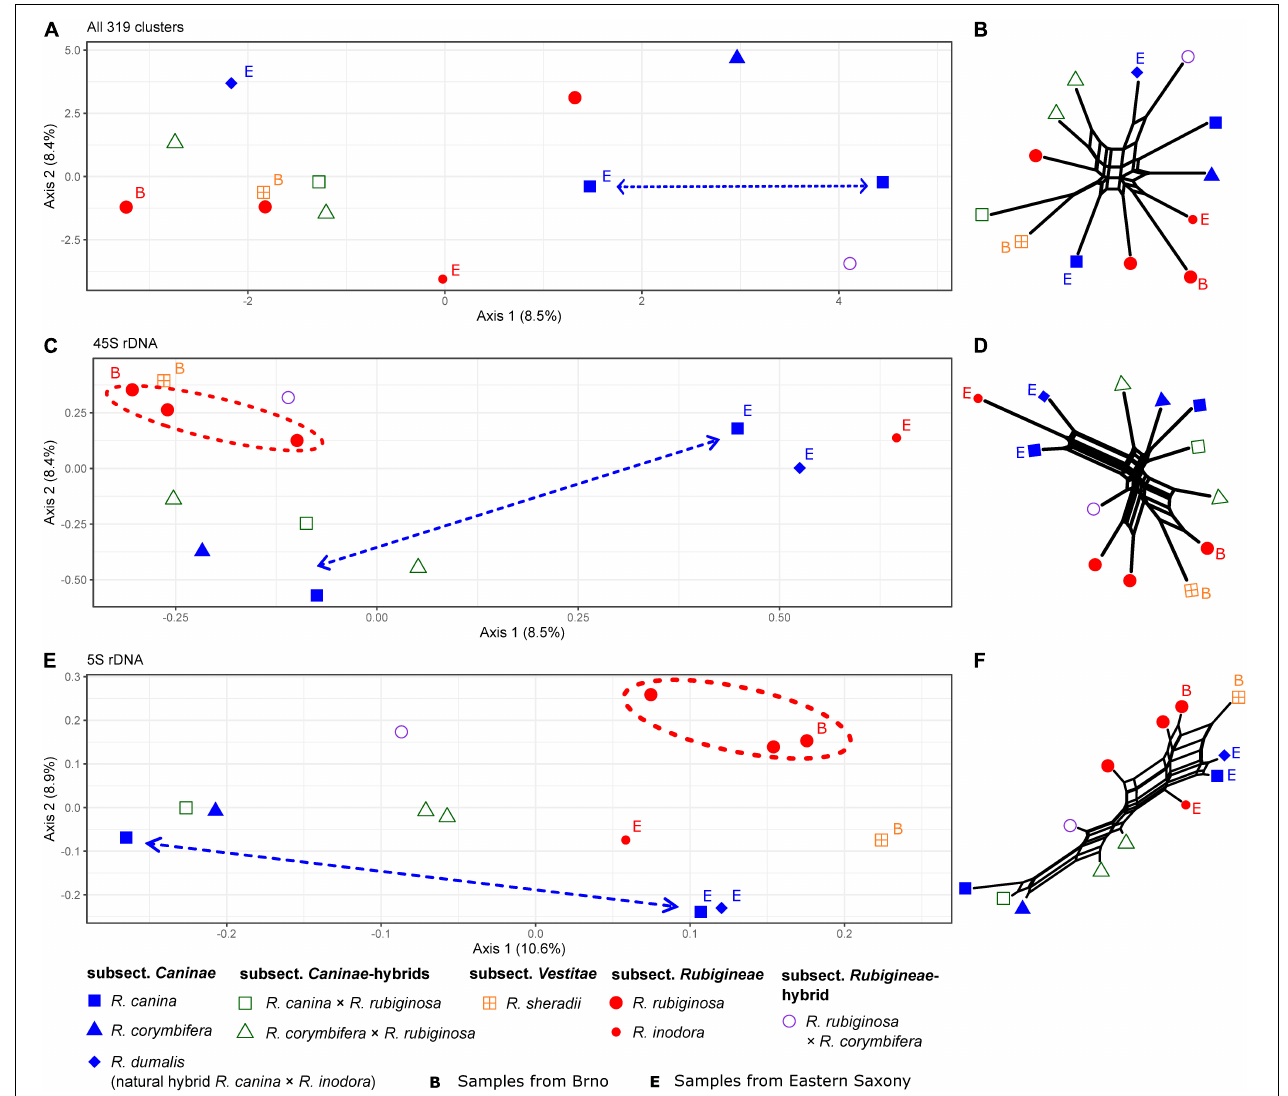
FIGURE 8 | Principal Coordinate Analyses of Rosa sect. Caninae , including natural and synthetic hybrids based on inverted and summarized observed/expected matrices from the comparative RepeatExplorer2 output and neighbor nets based on Gower distances calculated from those comparative RepeatExplorer2 outputs. Axis percentages explain the variance on the first two dimensions. (A) PCoA and (B) the neighbor net over all 319 clusters. (C,D) Only those five clusters with 45S rDNA hits and (E,F) cluster 108 with 5S rDNA hits. Unlabeled parental individuals and artificial hybrids were originally from Göttingen (Lower Saxony, Germany). The individuals from Eastern Saxony (Germany), including the natural hybrid R. dumalis , were labeled with (E) and roses from Brno (Czechia) with (B) . Note the clustering of R. rubiginosa (red) but not R. canina (blue) in all rDNA and graphs (C,D,E,F) . Large distances between R. canina indicated by dashed arrows and close R. rubiginosa by dashed